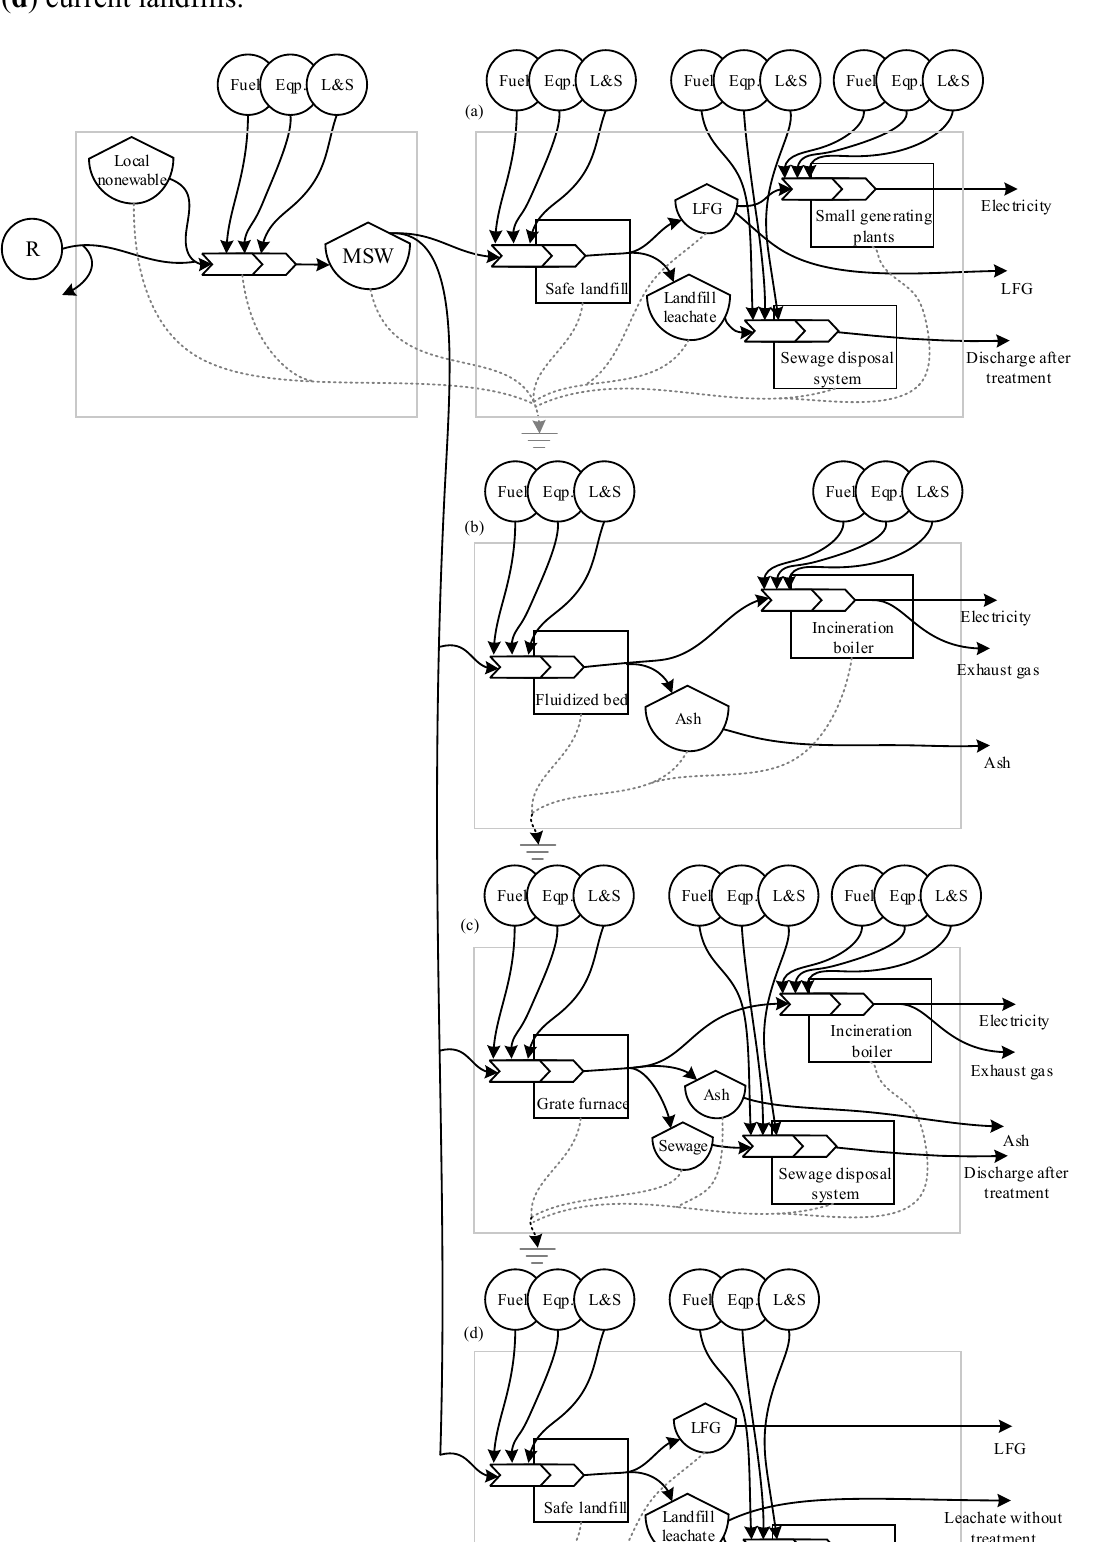
Figure 2. Emergy flow system diagram of four urban domestic waste treatment systems: ( a ) sanitary landfills; ( b ) fluidized bed incineration; ( c ) grate type incineration; ( d ) current